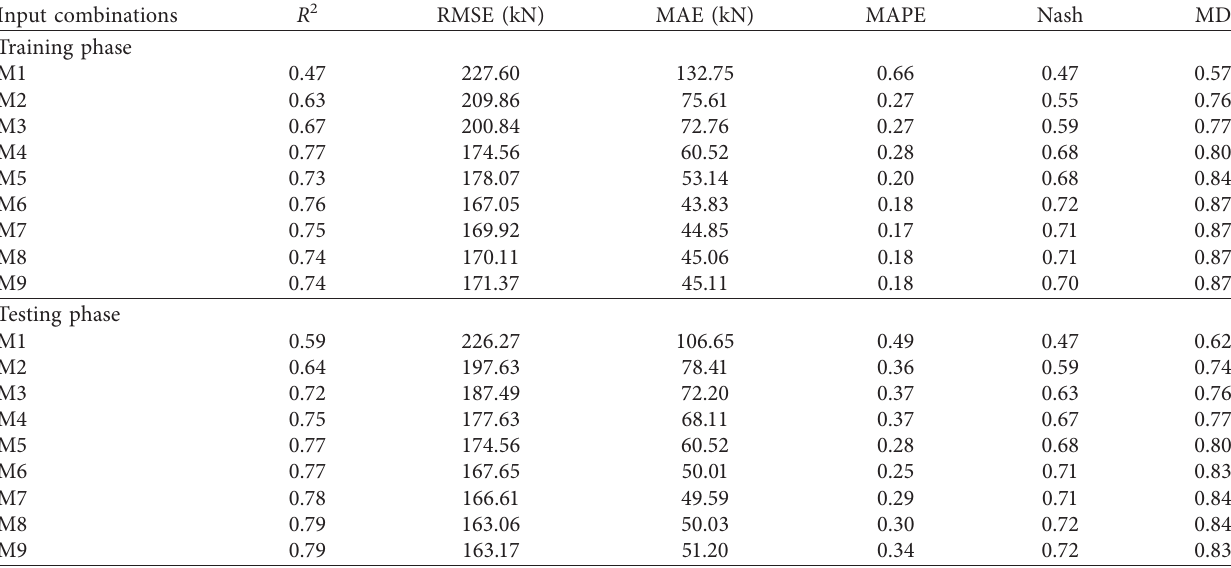
Table 3: The prediction results for the investigated nine input combinations over the training and testing phases for the proposed SVM